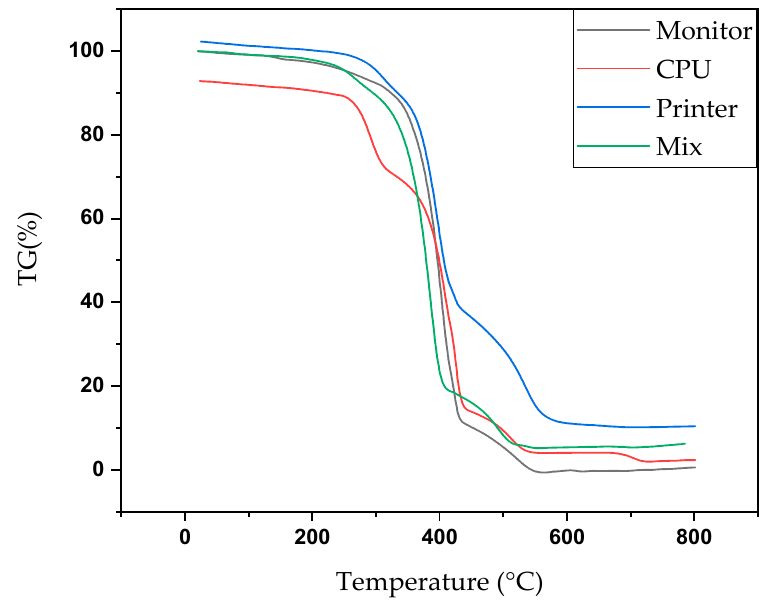
Figure 10. TG analysis of different computer parts comprising the mixed WEEE plastic feed used for thermal and catalytic cracking experiments.